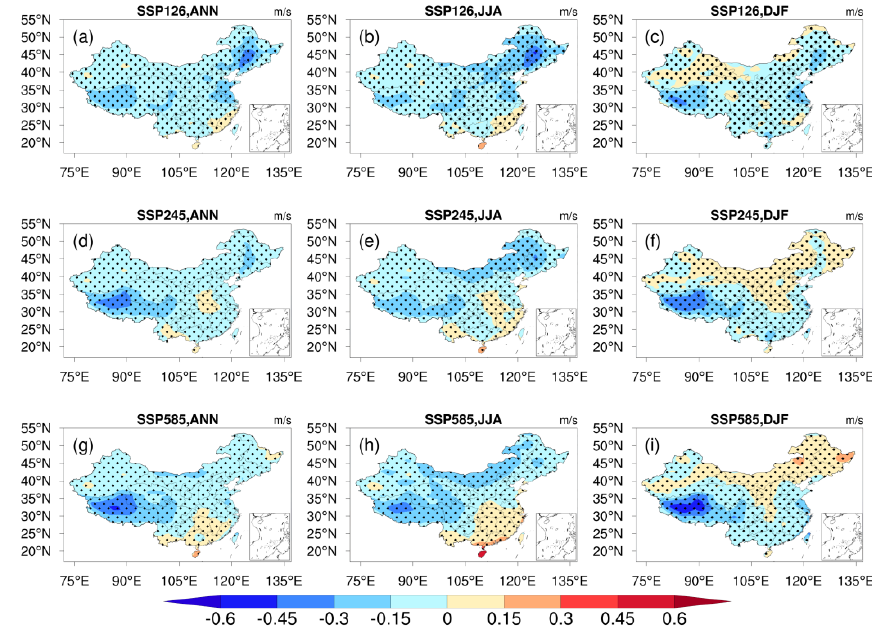
Figure 11. Same as Figure 10, but for the later period (2061 – 2100).